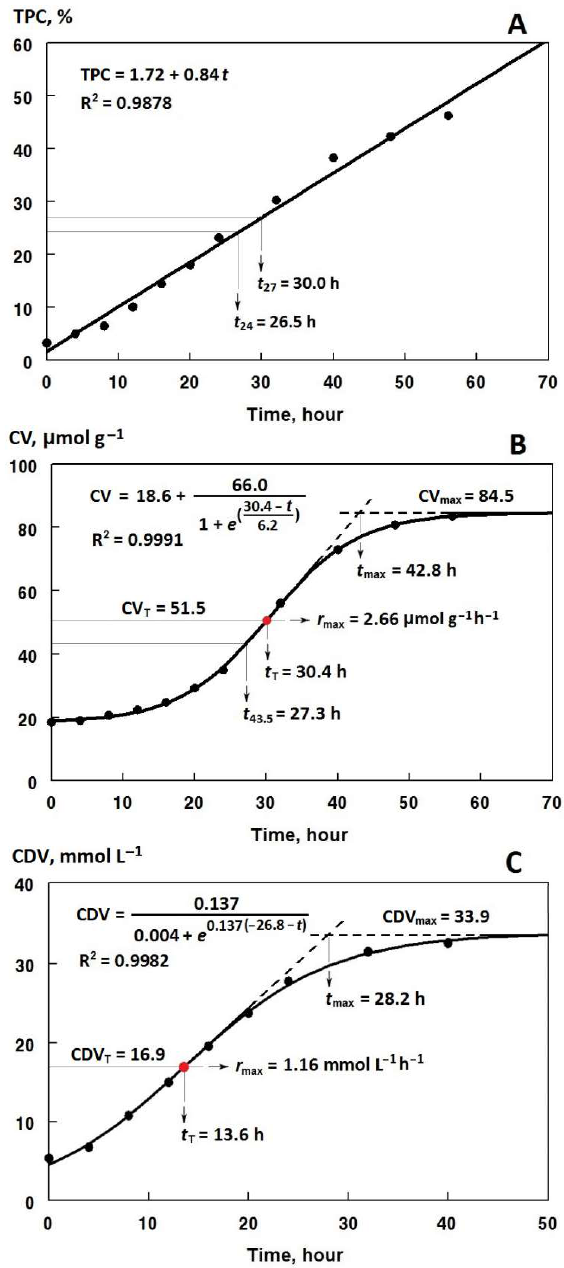
Figure 1. Kinetic curves of the accumulation of polar compounds (TPC, A ), carbonyls (CV, B ), and conjugated dienes (CDV, C ) during the frying of the oil sample A at 170 °C, and the kinetic parameters from the linear Equation (2) and the sigmoidal Equations (3) and (5) fitted on the whole range of the data points. t 24 and t 27 : the time required to reach TPCs of 24 or 27%, respectively; CV T /CDV T : CV/CDV at the turning point of the sigmoidal equations with the x-coordinates t T ; CV max /CDV max : the maximum CV/CDV levels attained at the values of t max ; r max : maximum rate of CV/CDV changes; t 43 . 5 : the time required to reach a CV of 43.5 μmol/g.